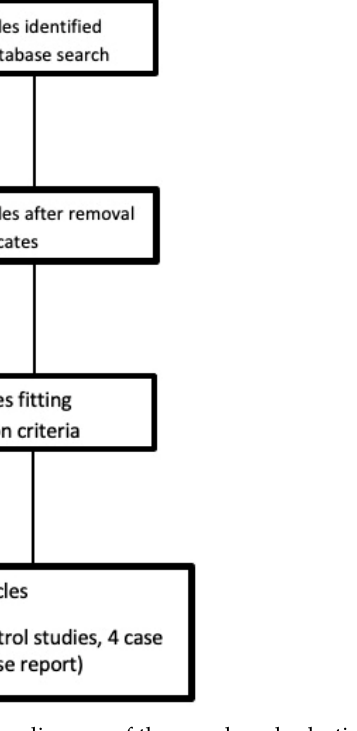
Figure 1. Flow diagram of the search and selection strategy of included articles.